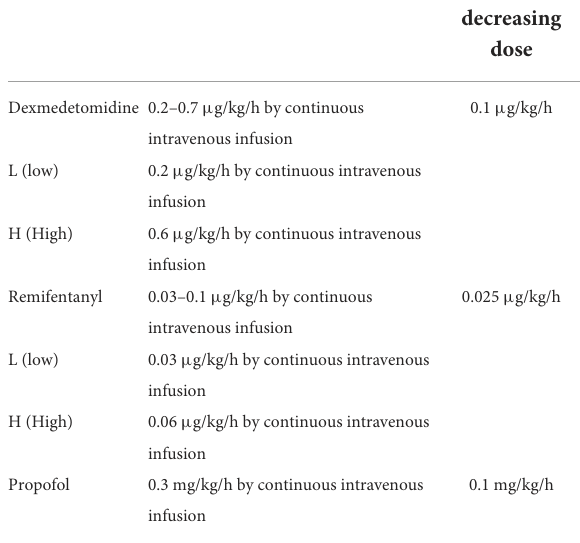
TABLE 2 Initial dose and increasing and decreasing dose of each sedative drug. Drug Initial dose Increasing